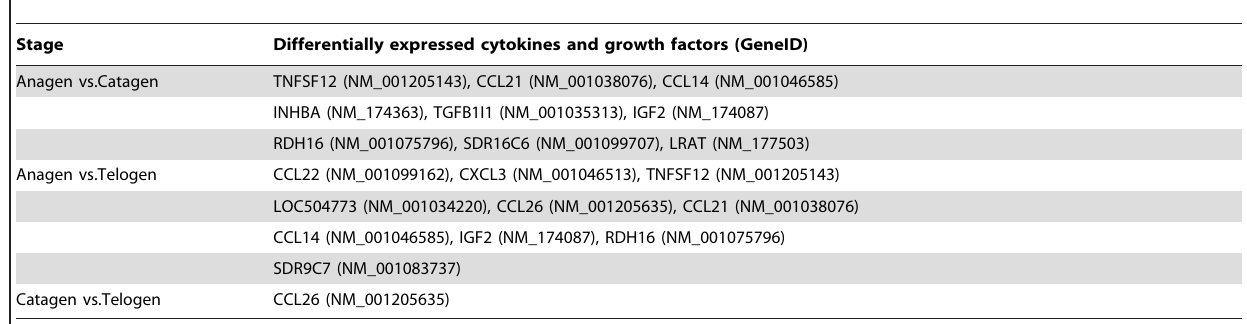
Table 4. List of possible cytokines and growth factors involved in cashmere goat hair follicle development and cycling.